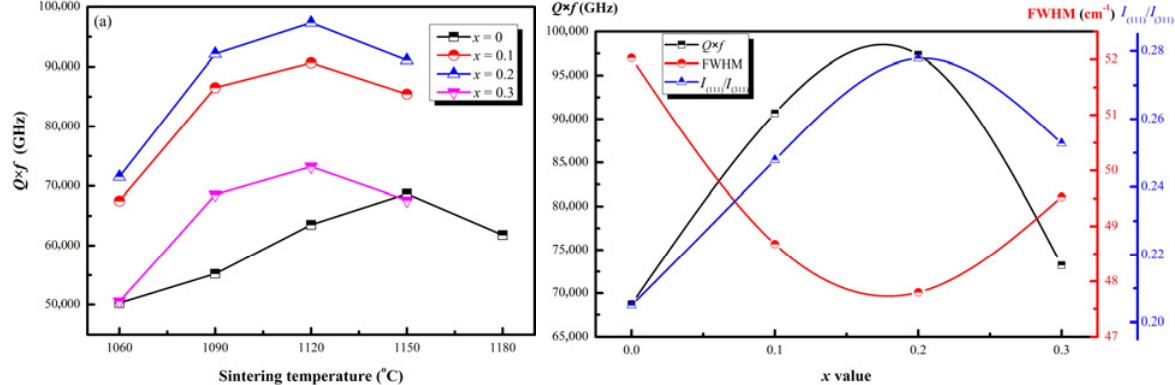
Fig. 9 (a) Variations of Q × f for LZTNN x ceramics sintered at various temperatures and (b) relationship between Q × f value, I (111) / I (311) , and FWHM of A 1g modes at about 718 cm − 1